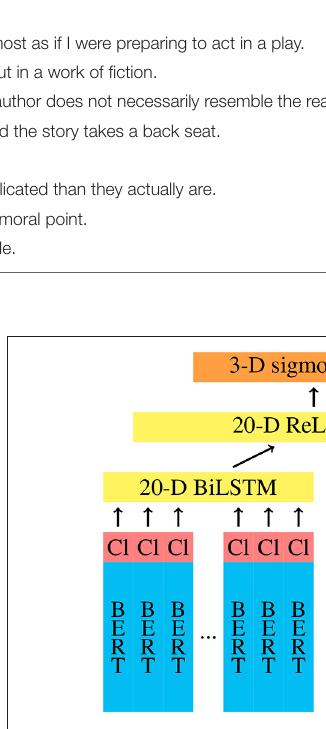
FIGURE 1 | Architecture of the neural network with annotator encoding (An), BERT embeddings, and clause encodings (Cl).